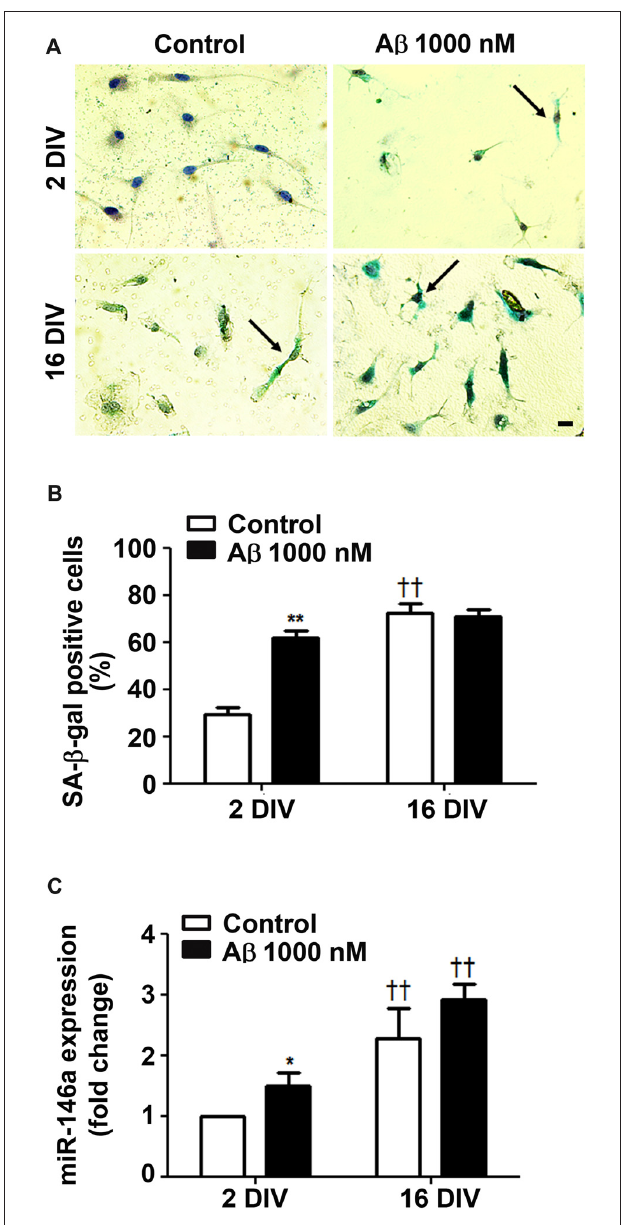
FIGURE 4 | Amyloid- β (A β ) peptide promotes cell senescence in reactive cultured microglia. Microglia that were kept in culture for 2 and 16 days in vitro (DIV) were treated with 1000 nM A β for 24 h. Activity of senescence-associated β -galactosidase (SA- β -gal) was determined using a commercial kit, and SA- β -gal-positive cells were counted. (A) Representative images of cells showing blue turquoise SA- β -gal staining. Scale bar equals 20 µ m. (B) Percentage of cells showing SA- β -gal-positive staining are expressed in graph bars as mean ± SEM. (C) MicroRNA (miR)-146a expression was evaluated by Real-Time PCR. Results are expressed in graph bars as mean ± SEM. Cultures, n = 4 per group. Two-way ANOVA ( Post hoc Bonferroni test): ∗ p < 0.05 and ∗∗ p < 0.01 vs. respective non-treated Control; †† p < 0.01 vs. 2 DIV cells; (B) DIV × A β interaction F ( 28.1 ) , p <